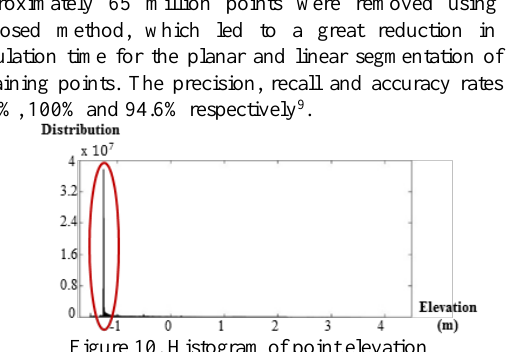
Figure 10. Histogram of point elevation